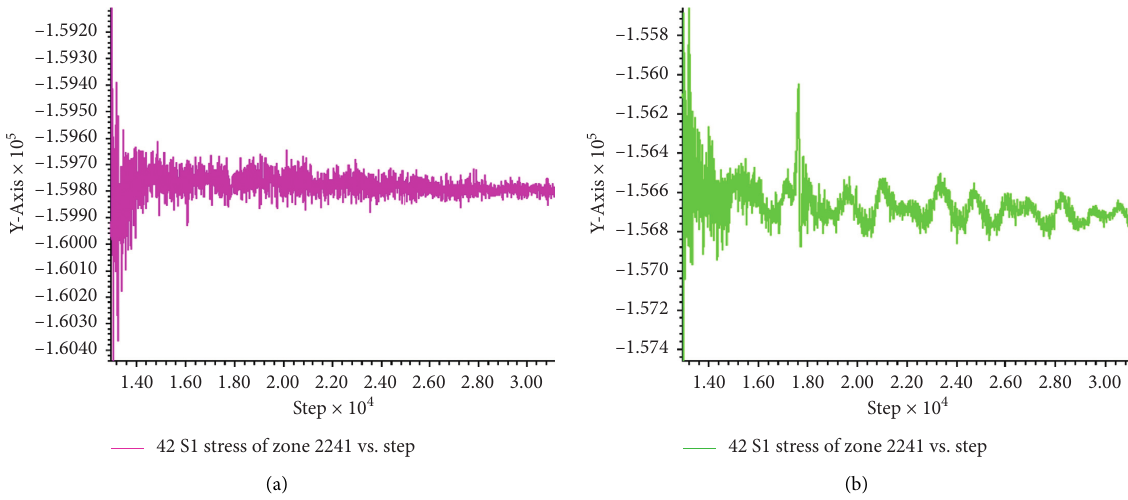
Figure 11: The maximum principal stress changes when the roadway moves horizontally for 10m: (a) left side and (b) right